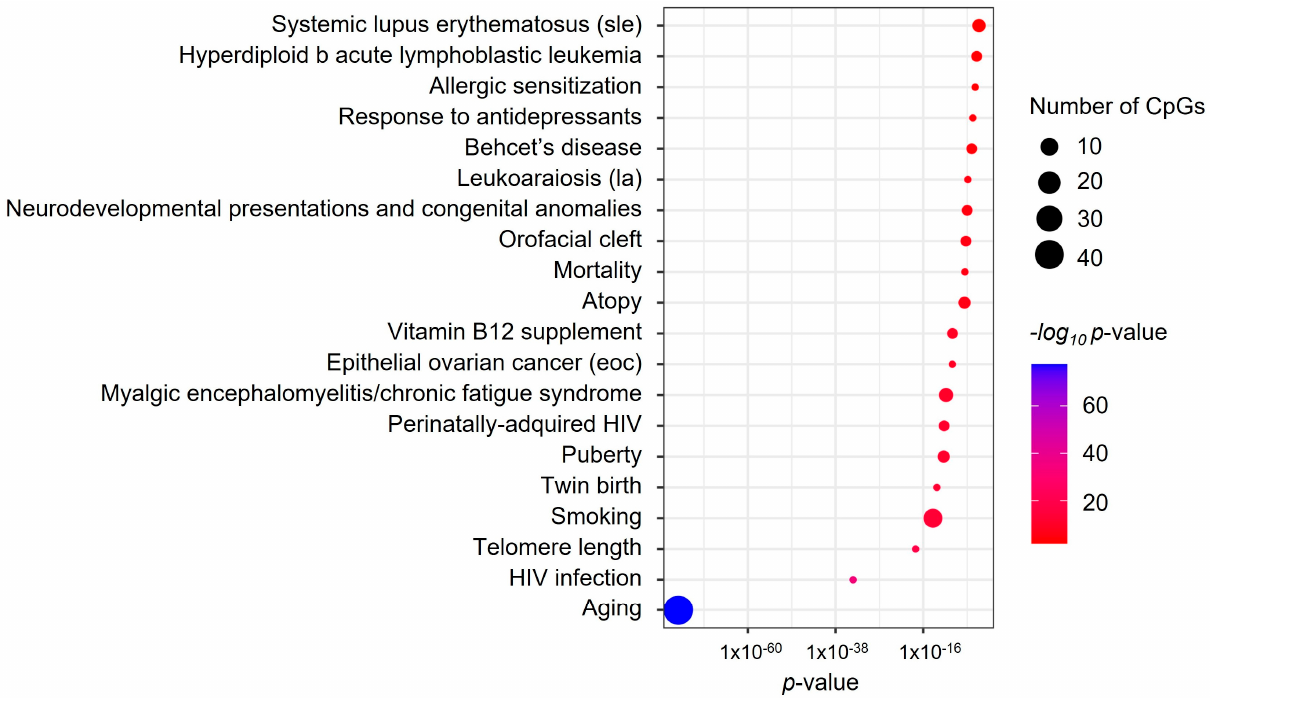
Figure 2. Summary plot of the trait-enrichment analysis for the top 100 CpGs associated with FeNO. p -values are displayed on the X-axis, and traits on the Y-axis. The color scale represents the significance of the association. The point size indicates the number of CpGs supporting the enrichment.